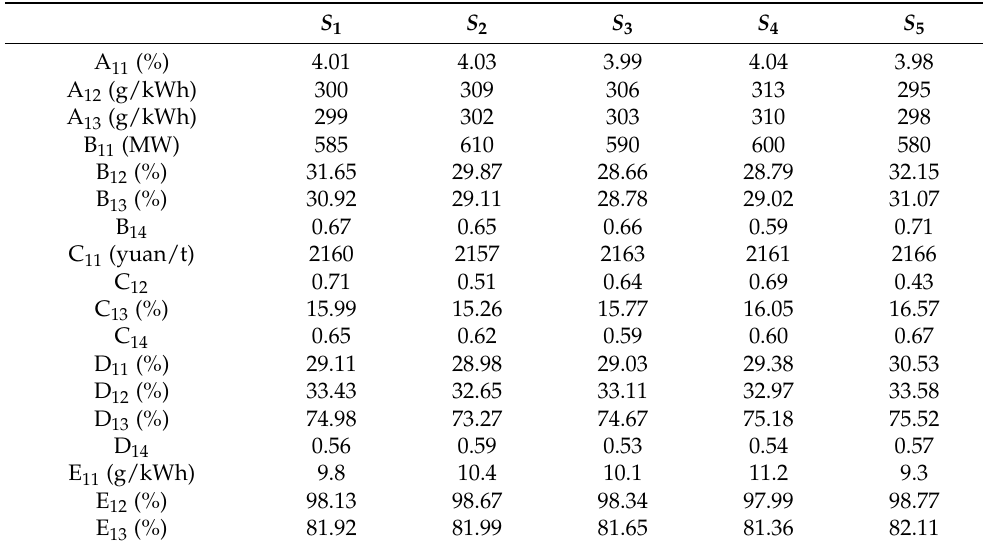
Table A1. Carbon emission comprehensive evaluation index parameters of coal power.